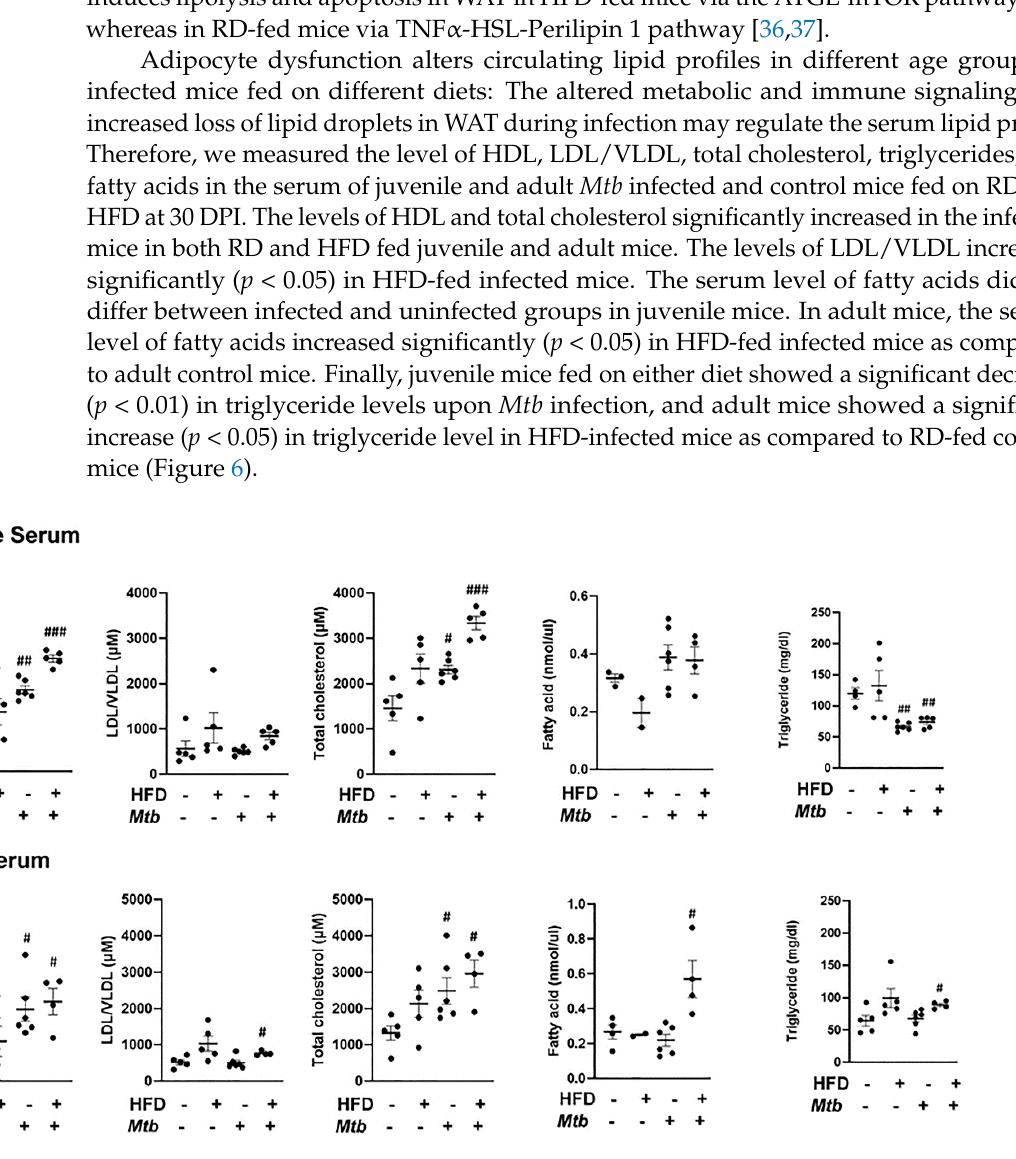
Figure 6. Changes in the circulatory levels of triglycerides, fatty acid, and cholesterol in different age group mice with infection fed on different diet at 30 DPI ( n = 5/group). ( a ) Serum levels of HDL, LDL/VLDL, total cholesterol. fatty acid and triglyceride in juvenile mice measured by ELISA. ( b ) Serum levels of HDL, LDL/VLDL, total cholesterol. fatty acid and triglyceride in adult mice meas- ured by ELISA. The error bars represent standard error of the mean. # p < 0.05, ## p < 0.01, and ### p < 0.001, compared to uninfected RD mice.